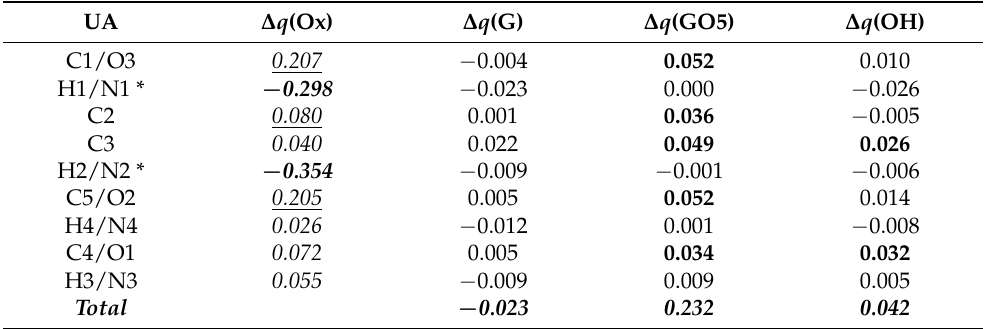
Table 6. Change in partial charge ∆ q of each atom group of a uric acid (UA) from the neutral state to the oxidized state ( ∆ q (Ox)), and the bound state with the pristine graphene ( ∆ q (G)), GO5-para ( ∆ q (GO5)), and G(OH)5-paraA ( ∆ q (OH)). For the oxidized molecule (italic), the ∆ q of oxidized sites (bold) and their adjacent atom groups (underlined) are highlighted. For the bound molecules, the ∆ q of atom groups losing more than 0.025 electrons to the substrate via adsorption (bold) are highlighted. Oxidation sites are labeled by ‘*’. ∆ q (Ox) ∆ q